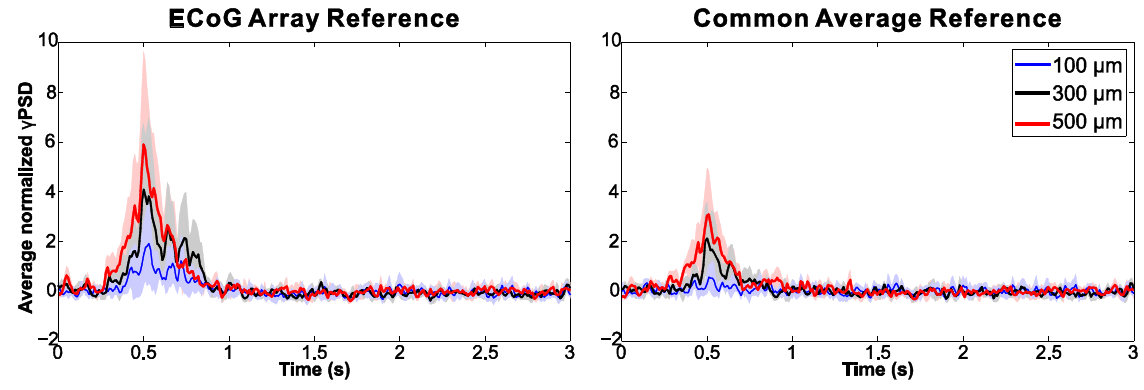
Figure 17. Time course of normalized gamma-PSD ± s.d. derived from time-frequency plots (shown in Figure 16), using a skull-facing reference electrode ( Left ) and common average referencing ( Right